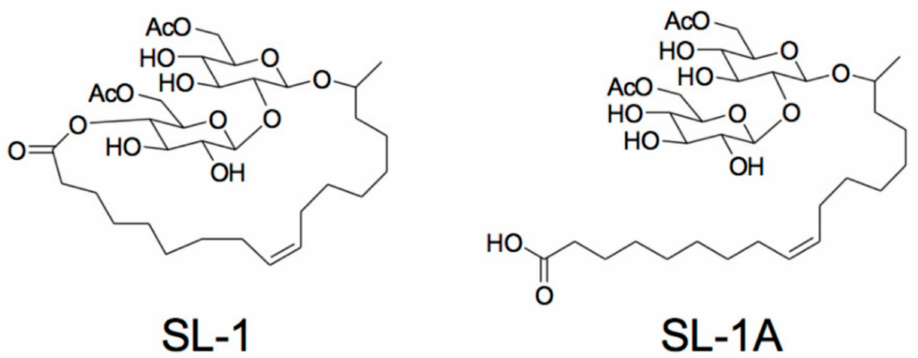
Figure 1. Structures of the sophorolipids predominantly produced by S. bombicola . The 17-L-[(2 (cid:48) -O- β - glucopyranosyl- β -D-glucopyranosyl)-oxy]-9-octadecenoic acid 1 (cid:48) ,4”-lactone 6 (cid:48) ,6”-diacetate (SL-1) and its free acid form (SL-1A) (Adapted from